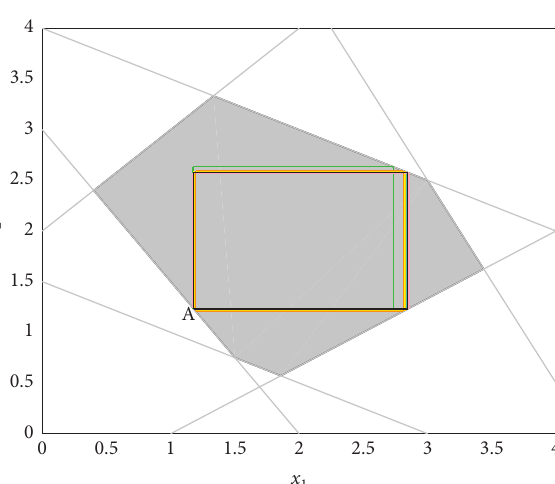
Figure 4: Example 1: the gray region is the complete solution space. The regions are obtained by the following methods: the exact (red), GHZ (green), CES-IA (yellow), d CMA-ES-IA (cyan), SA-DIRECT with T � 150and β � 0 . 98 (pink), SA-DIRECT with T 0 . 94 (gold), SA-DIRECT with T 0 � 8and d � 1 (magenta), and d CMA-ES-DIRECT with d d s c